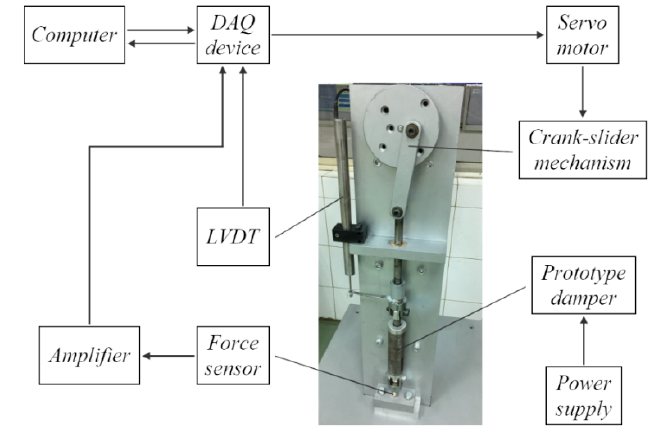
Figure 12. Experimental setup for testing the performance of the prototype self-powered MR damper.